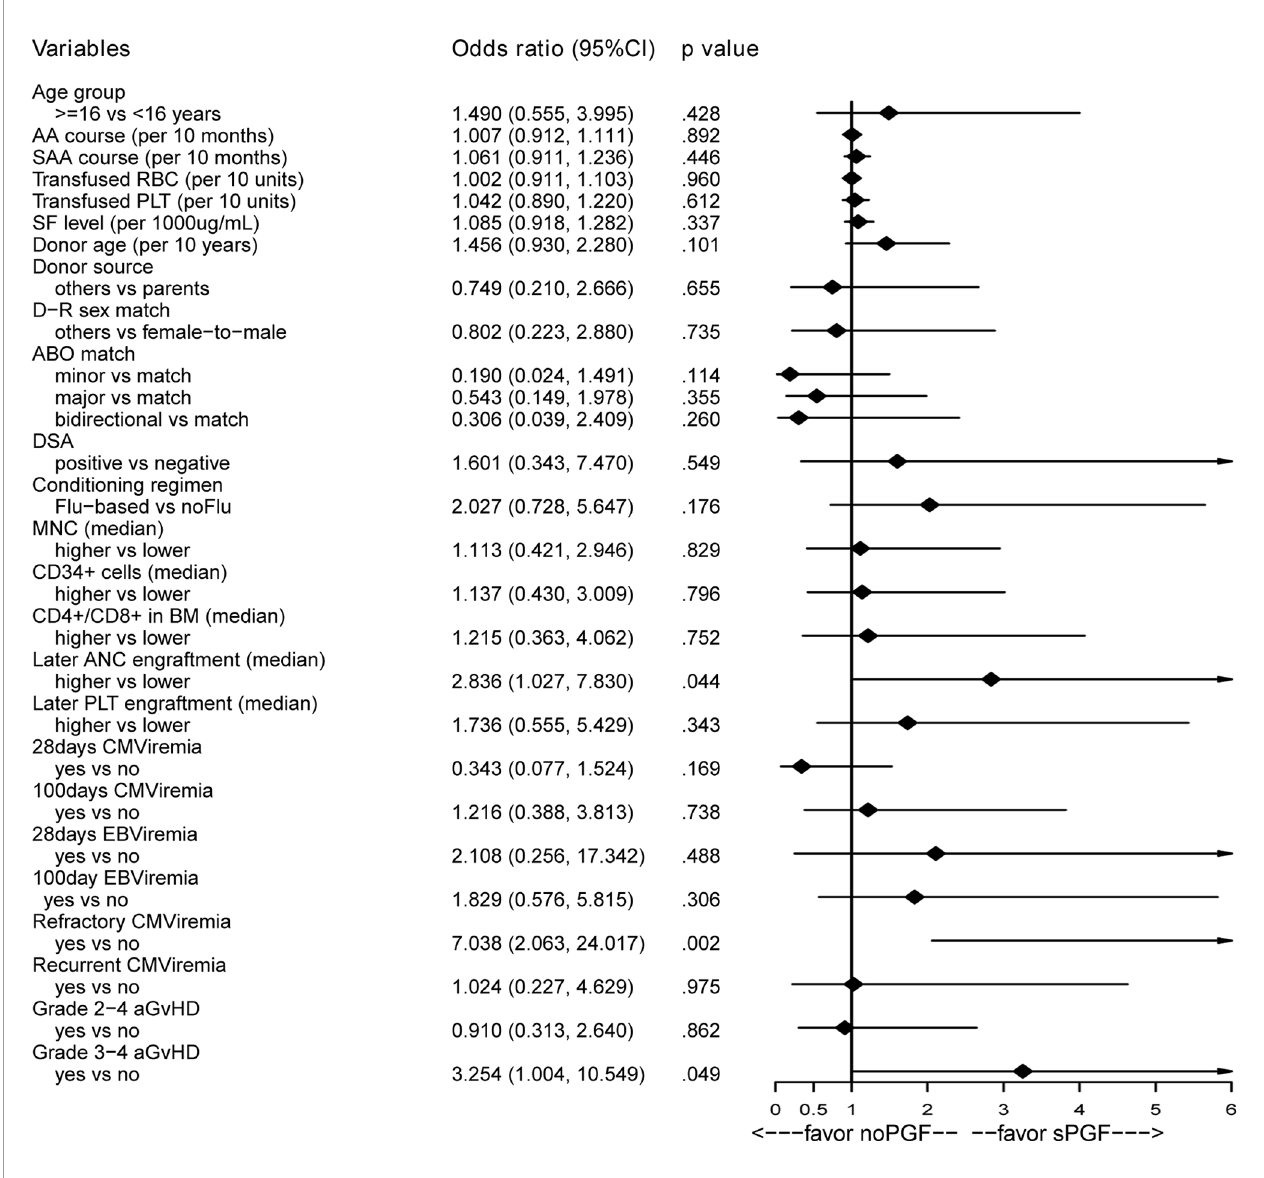
FIGURE 4 | Univariable analysis of risk factors associated with sPGF.